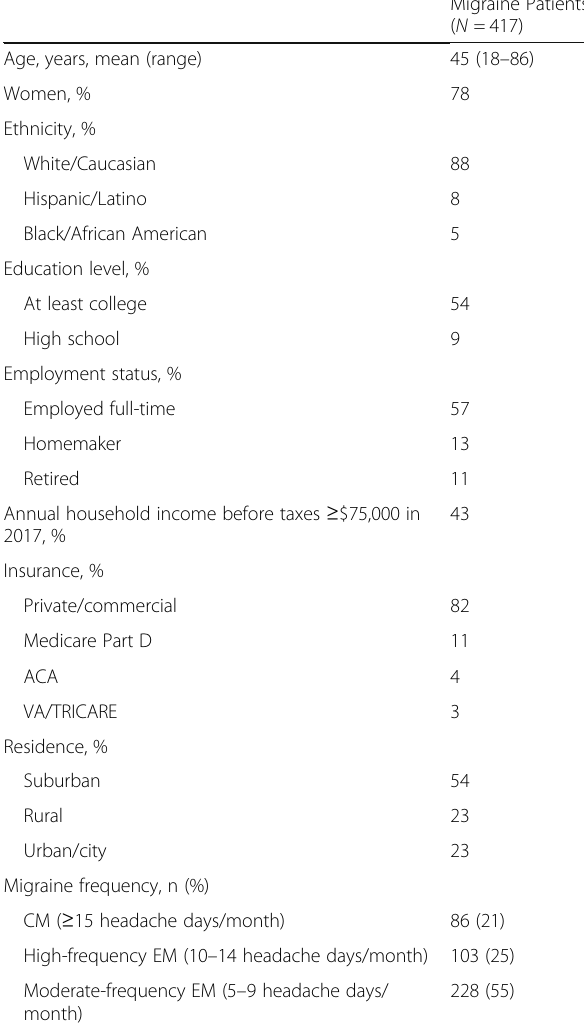
Table 2 Demographics and baseline characteristics of survey participants (patients with migraine)